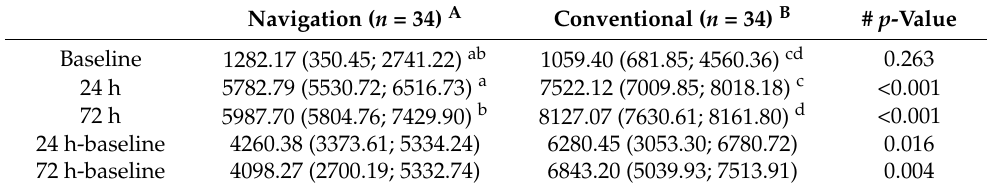
Table 5. Serum interleukin-8 concentrations (pg/mL) before TKA, then at 24 and 72 h after TKA.